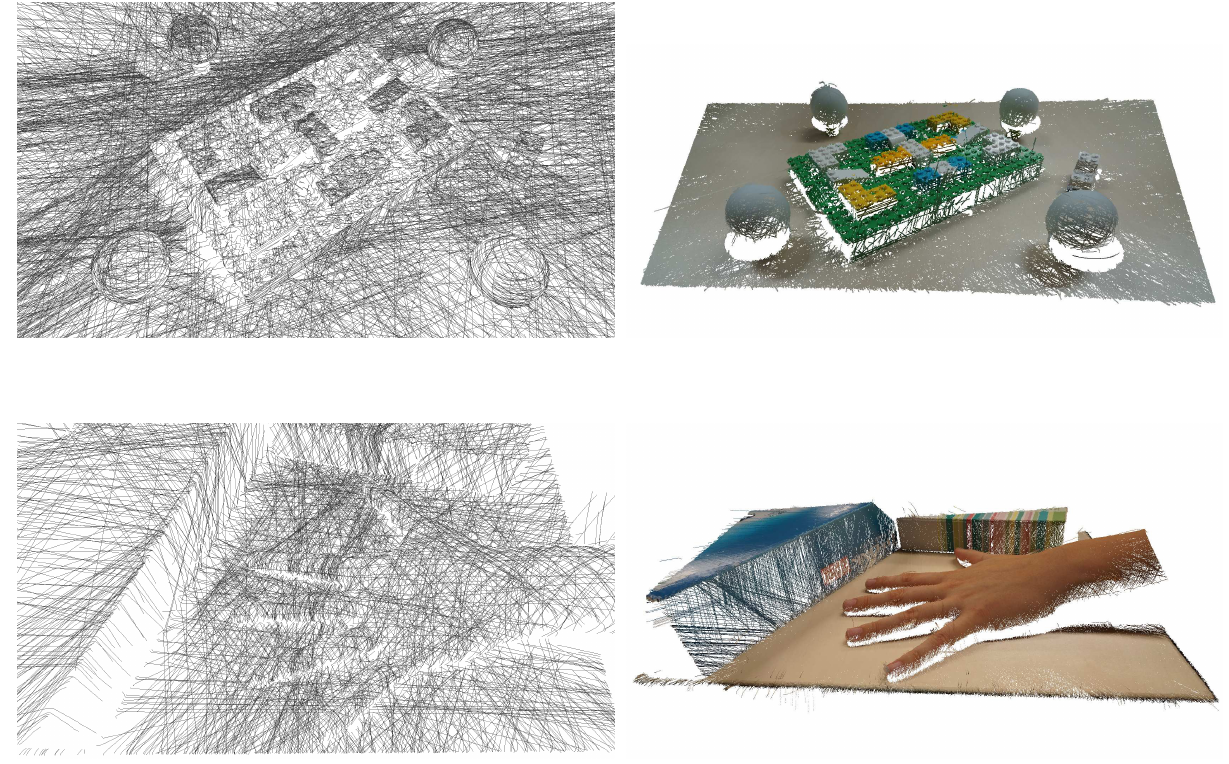
Figure 5: Subset of the extracted laser lines on the left and reconstructed point cloud on the